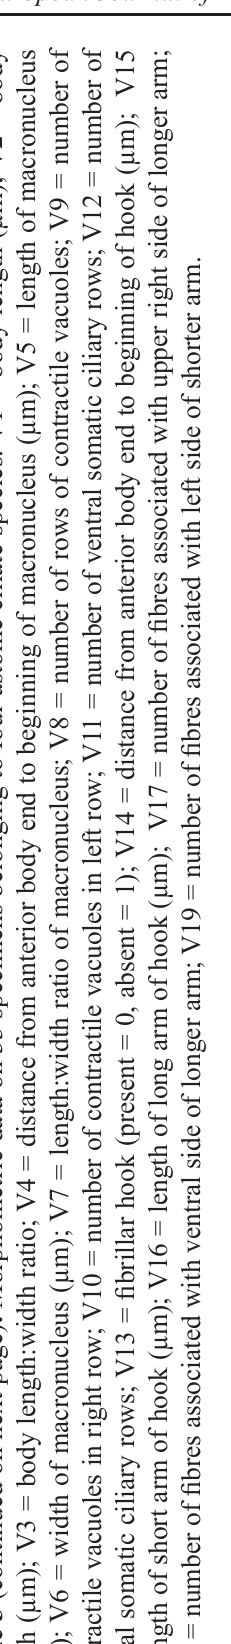
= 3 V ; m ) µ ( h d t w i